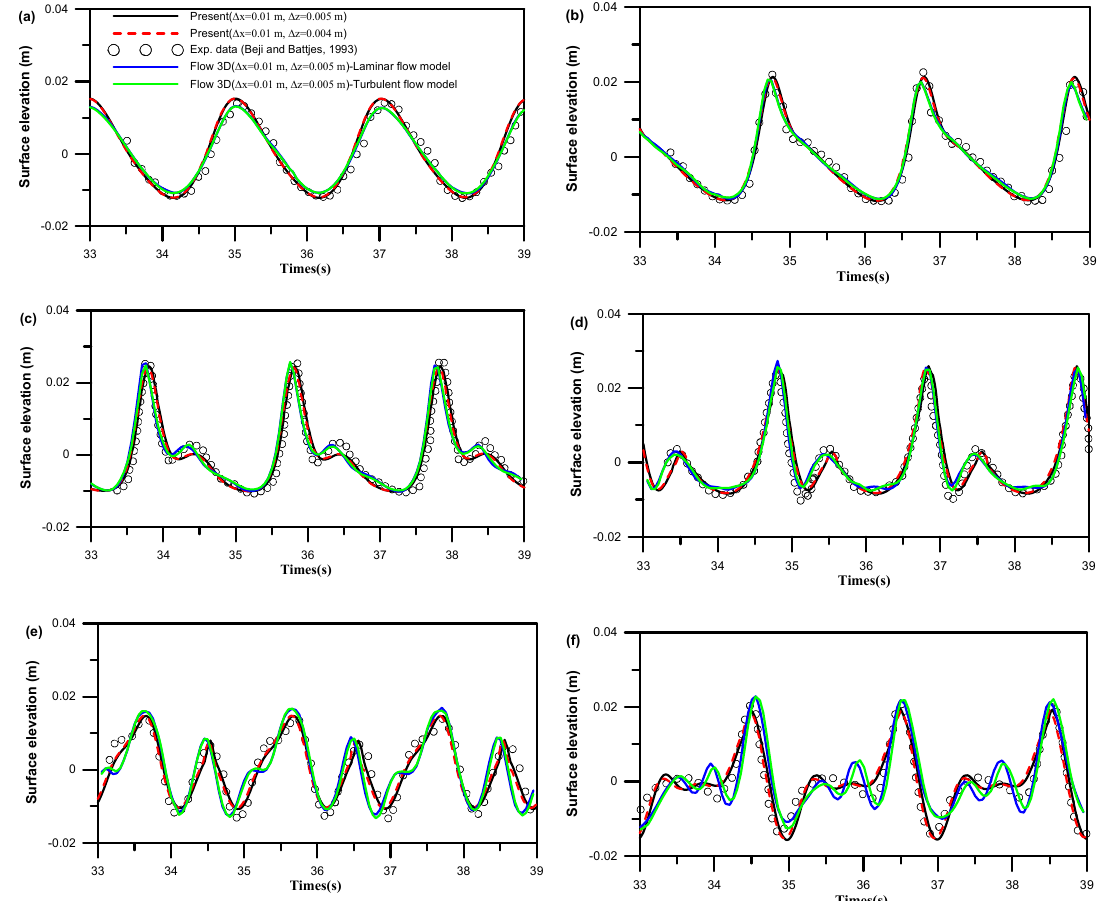
Figure 17. Free surface elevations on six wave gauges ( a ) x = 18.5 m; ( b ) x = 20.5 m; ( c ) x = 21.5 m; ( d ) x = 22.5 m; ( e ) x = 23.5 m; ( f ) x = 25.5 m.